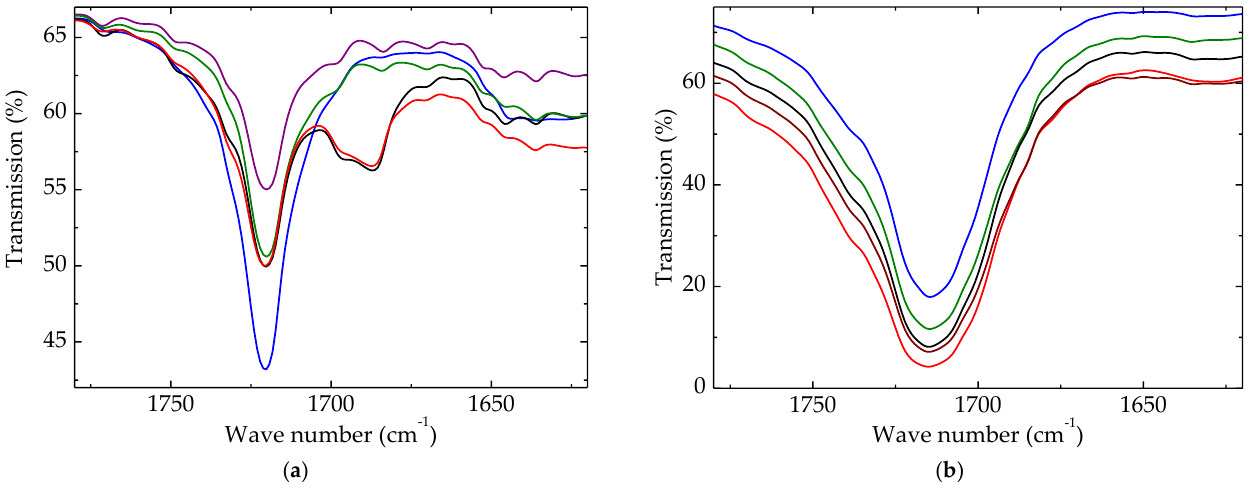
Figure 7. Carbonyl regions of FTIR spectra for polyethylene blends. Irradiation dose: ( a ) 0 kGy; ( b ) 100 kGy. ( --brown ) LDPE/UHMWPE; ( --red ) LDPE/HAp; ( --black ) LDPE/HAp/RM; ( --green ) LDPE/UHMWPE/HAp; ( --blue ) LDPE/UHMWPE/HAp/RM.